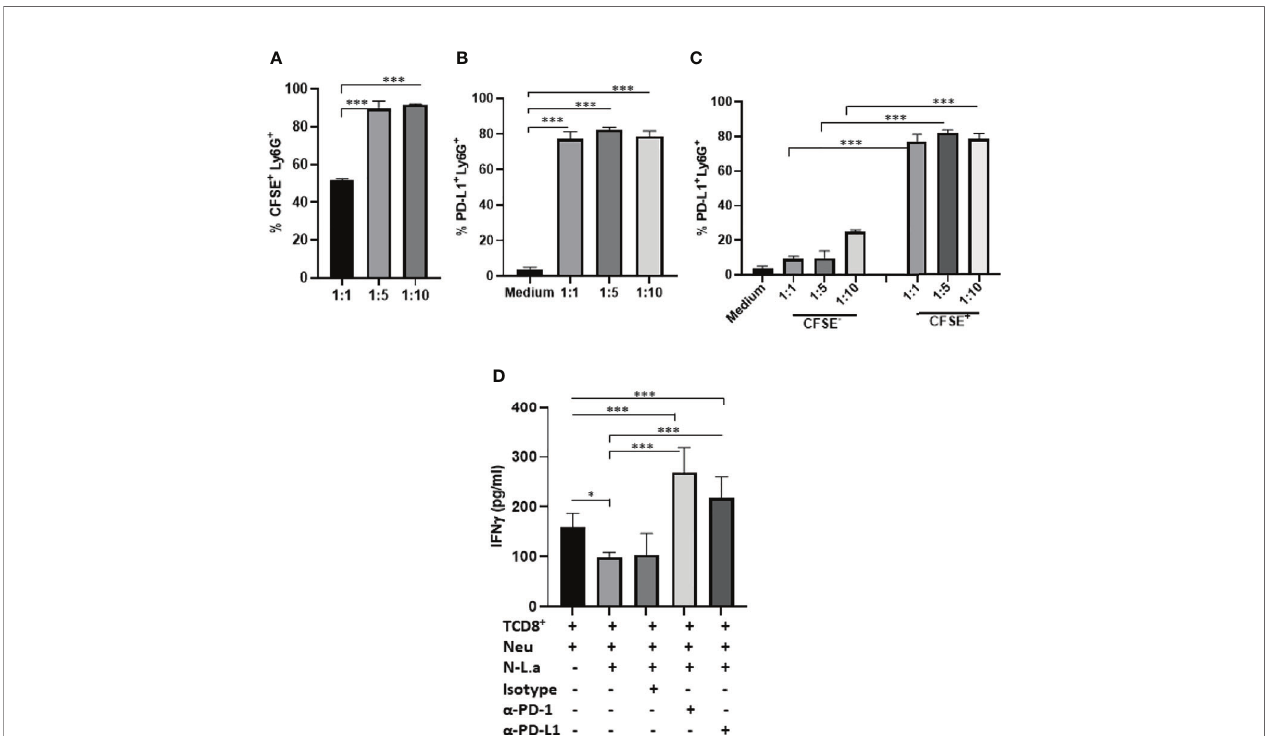
FIGURE 6 | Coculture of murine neutrophils exposed to L. amazonensis with CD8 + T activated cells. C57BL/6 neutrophils (5x10 5 ) recruited to the peritoneum with casein were incubated with CFSE-stained promastigotes (Pro) of L. amazonensis (1:1, 1:5, 1:10), for 4 h. Control performed with neutrophils on medium. Cells were then analyzed by fl ow cytometry using Ly6G + -Percp (neutrophils), CFSE + ( L. amazonensis ) and PD-L1 + -APC. (A) Percentage of CFSE + Ly6G + cells. (B) Percentage of PD-L1 + Ly6G+ cells. (C) Percentage of PD-L1 expression on CFSE - (bystander) and CFSE + cells. (D) Coculture of murine neutrophils (Neu) infected or not with promastigotes of L. amazonensis (Leish) with CD8 + T effectors cells. The coculture was treated or not with anti-PD-1 or anti-PD-L1 or isotype control for 18h. IFN- g was analyzed in the culture supernatant by ELISA. Data are mean ± SEM. (A – C) N=3-4 and (D) N=7. *p=0.049, ***p < 0.001.